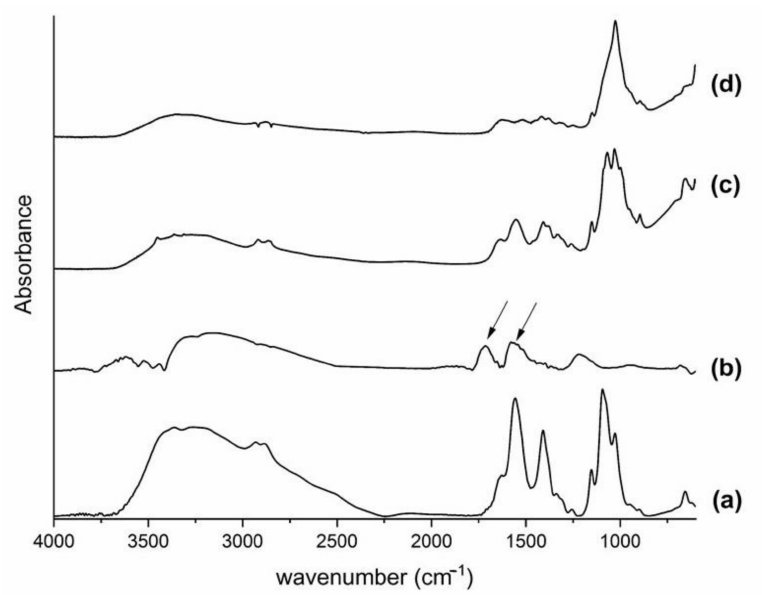
Figure 1. FTIR spectra of ( a ) chitosan, ( b ) carbon nanotubes, ( c ) CN25 and ( d )